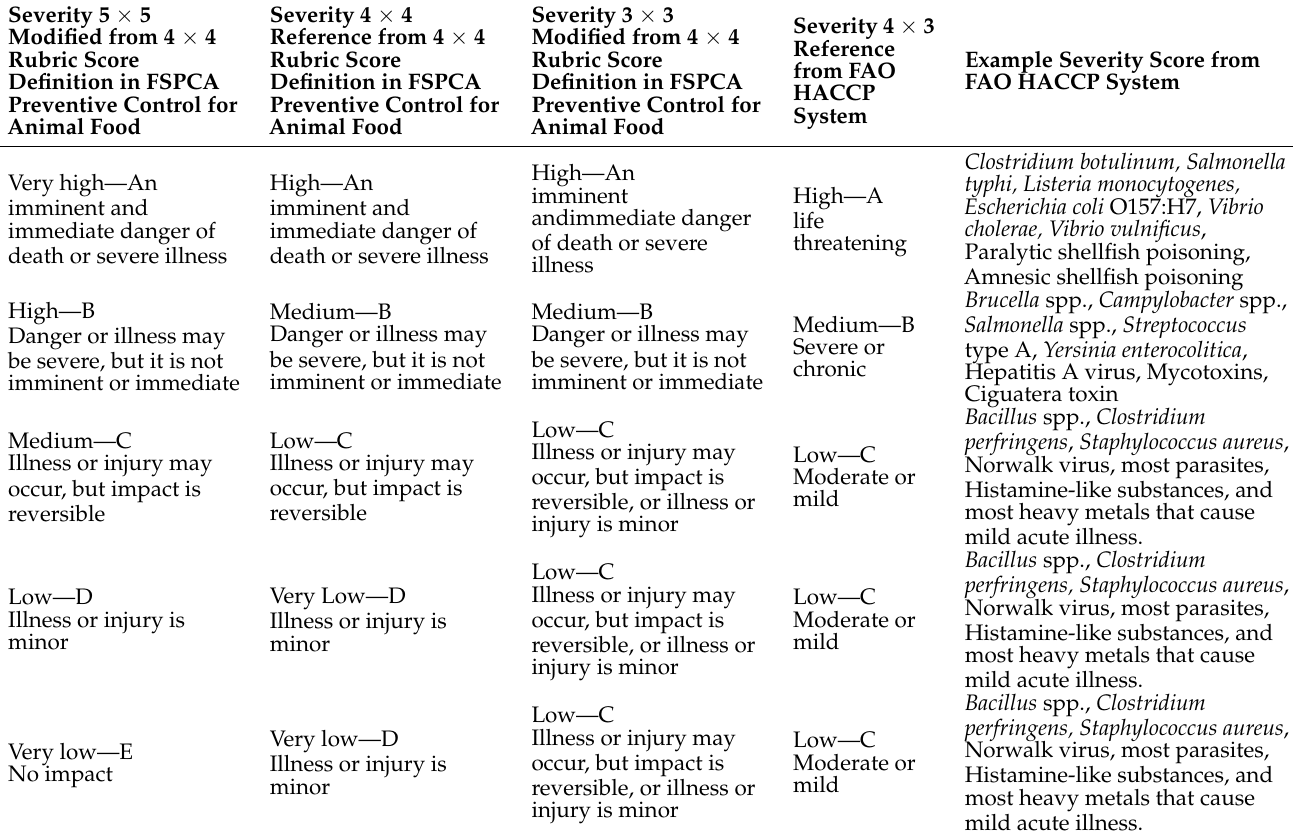
Table 5. All qualitative food safety risk matrix models’ severity scores